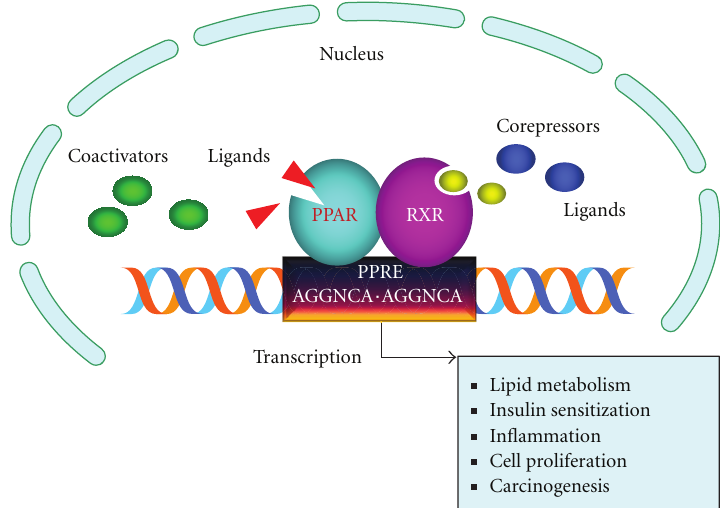
Figure 1: A basic mechanism of PPAR signaling. Following ligand binding, PPAR forms a heterodimer with RXR, which binds to the PPRE of target genes and regulates the transcription of these